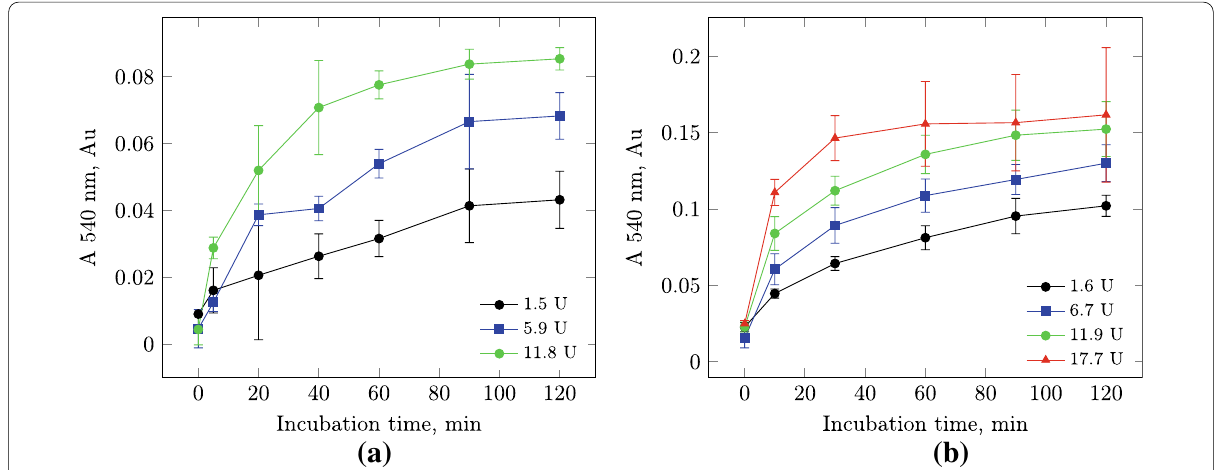
Fig. 3 Kinetic dependence of the accumulation of TCA-soluble peptides during the hydrolysis of soy protein isolate (SPI) on the number of protosubtilin activity units (PS) (40 ◦ C, in deionized water). a On a laboratory scale; b on a semi-industrial